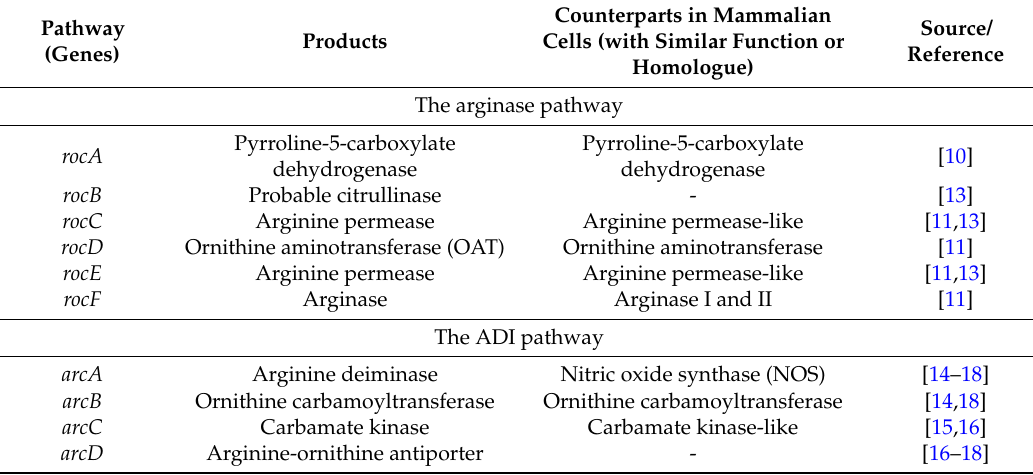
Ornithine aminotransferase (OAT) Ornithine